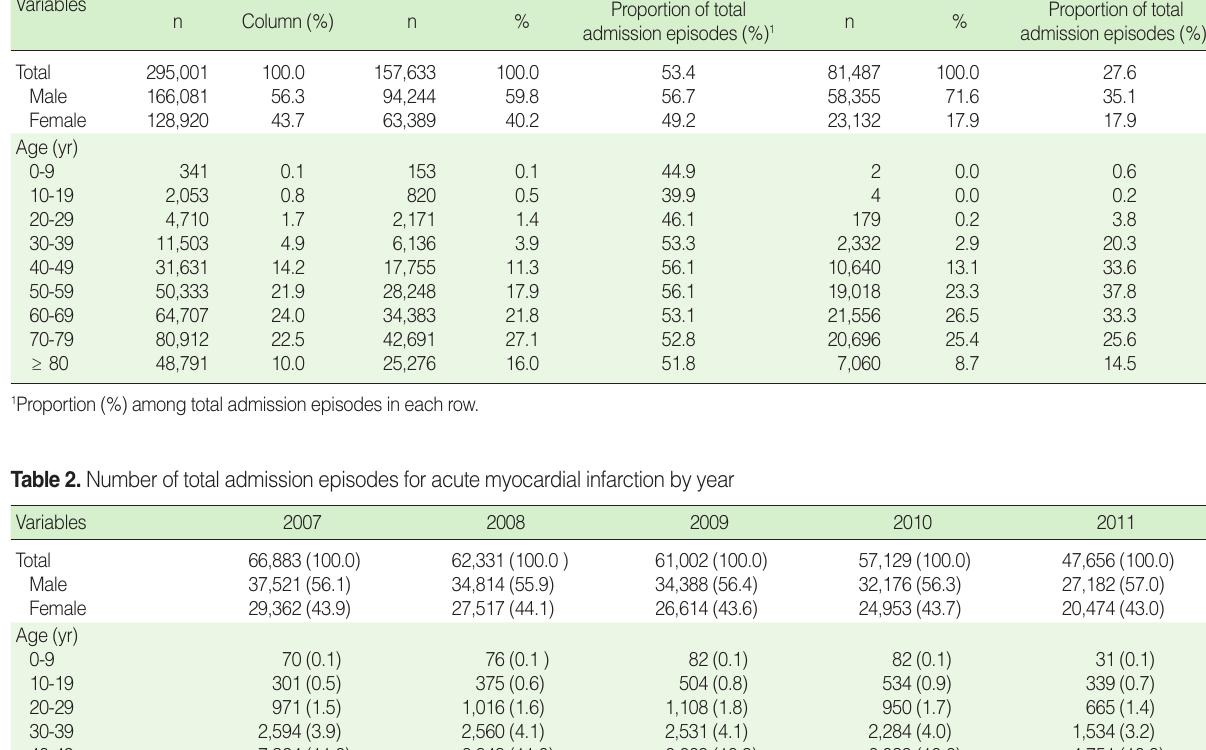
Table 1. Characteristics of patients admitted for acute myocardial infarction, 2007­2011 Variables